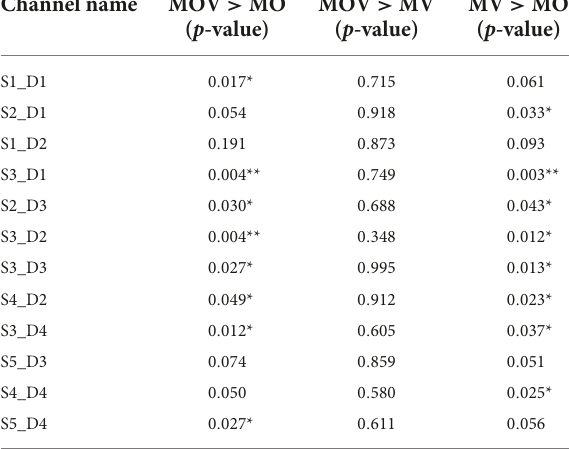
TABLE 1 Differences in channel cortical oxyhemoglobin content amplitude between move hand and vibration stimulation (MV), move hand and observe video (MO), move hand and observe video and vibration stimulation (MOV) tasks at 5 s of the recovery